Question: Briefly state, in one sentence, what is plotted here.
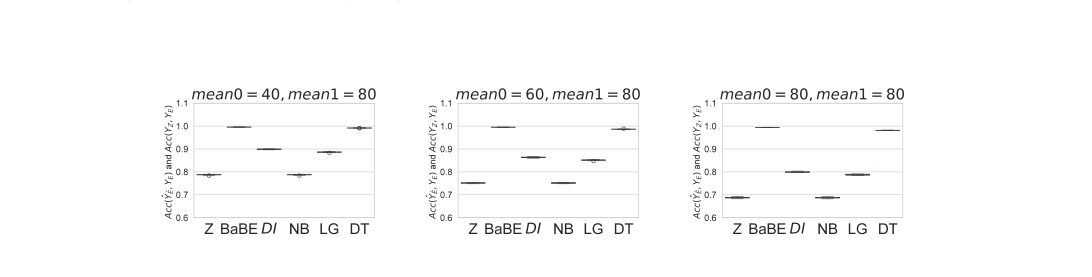
Answer: Experiments on the synthetic data sets: The accuracy between ˆ𝑌𝑍and 𝑌𝐸, and between ˆ𝑌ˆ𝐸and 𝑌𝐸.